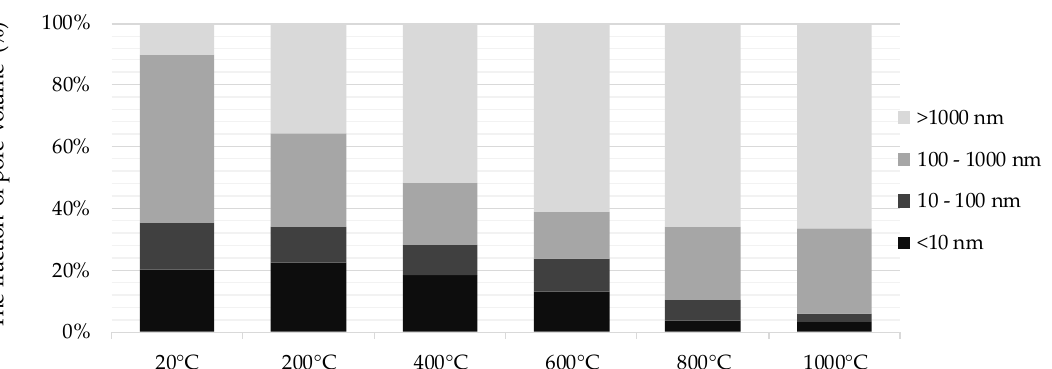
Figure 5. Categorization of pores for mortars with GGBFS (M50), depending on the temperature applied to the material.